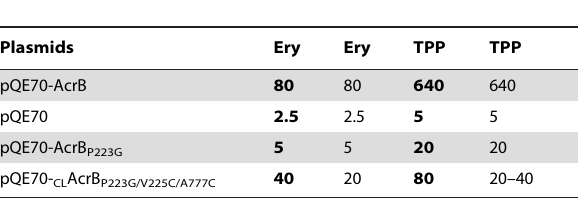
Table 2. MIC ( m g/ml) of BW25113 D acrB containing plasmid encoded AcrB measured in the presence (no bold) or absence (bold) of 4 mM